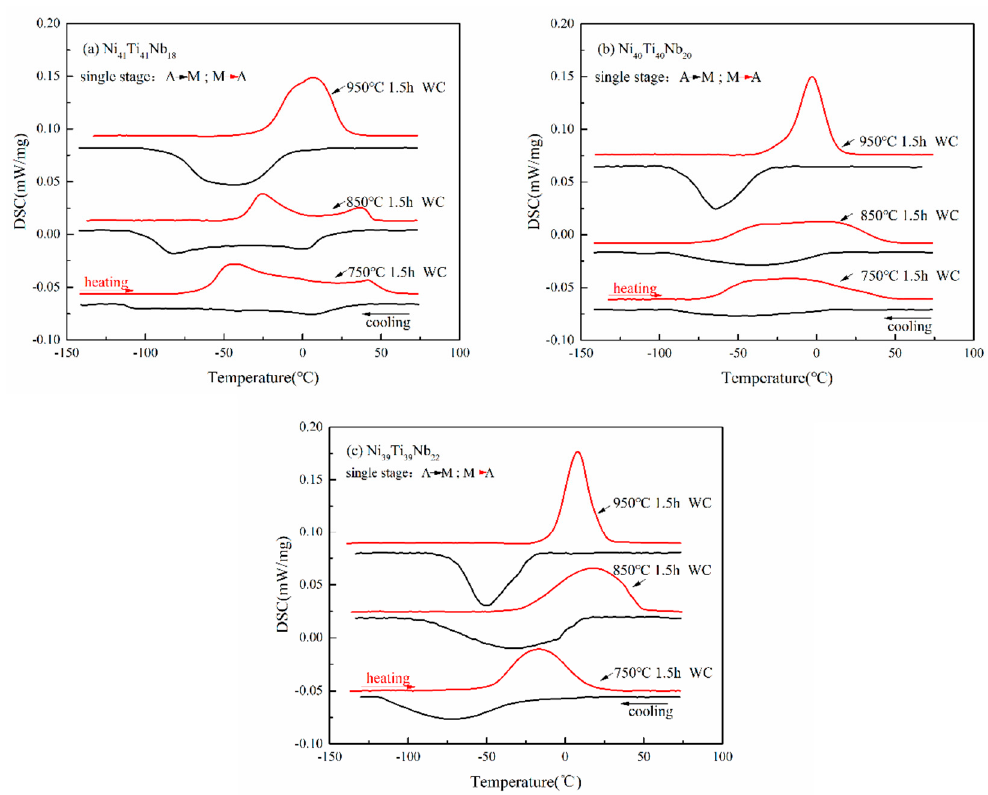
Figure 3. DSC curves of Ni50 − x /2Ti50 − x /2-Nb x ( x = 18, 20, 22) alloys annealed at different temperature. ( a ) DSC curves of Ni41Ti41Nb18 alloy; ( b ) DSC curves of Ni40Ti40Nb20 alloy; ( c ) DSC curves of Ni39Ti39Nb22 alloy.